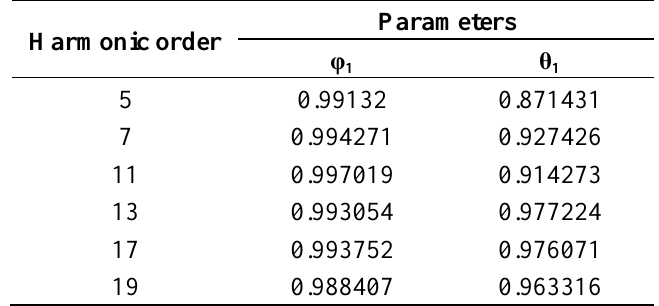
Table 1. Parameters of ARMA (1,1) model.